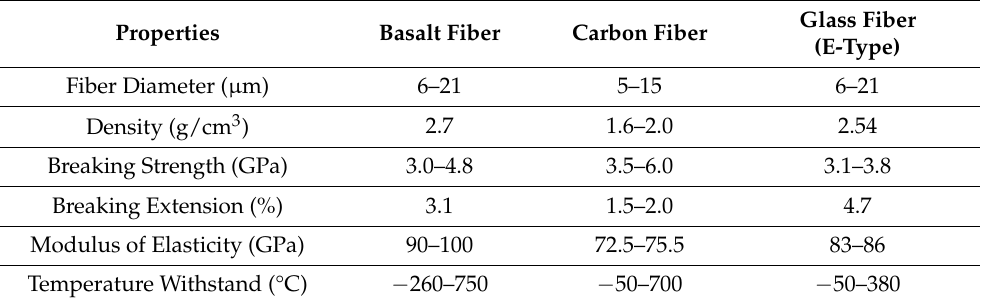
Table 2. Comparison of selected properties of basalt, glass, and carbon fibers (based on [59–64]).